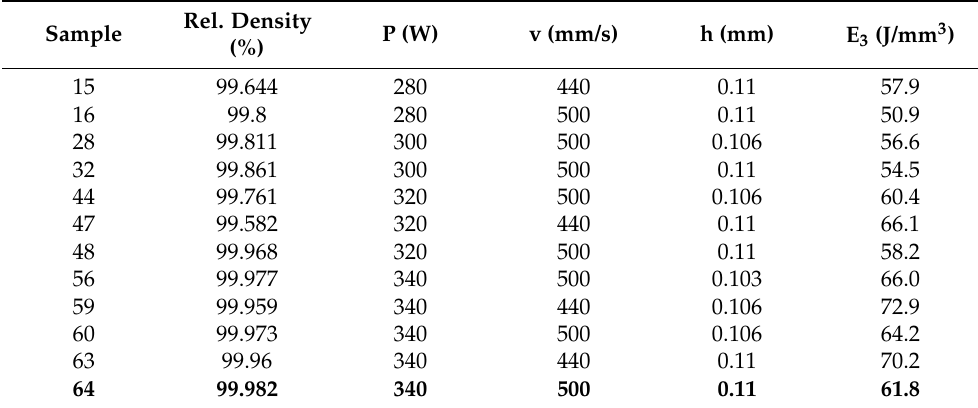
Table 12. The resulting relative density of selected samples after the 2nd